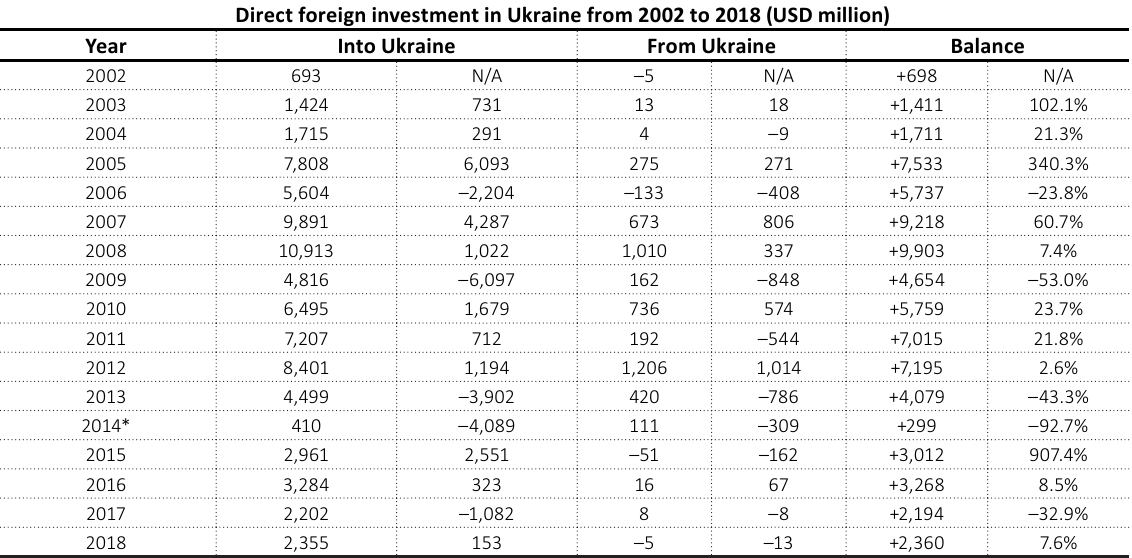
Table 1. The volume of direct foreign investments in the economy of